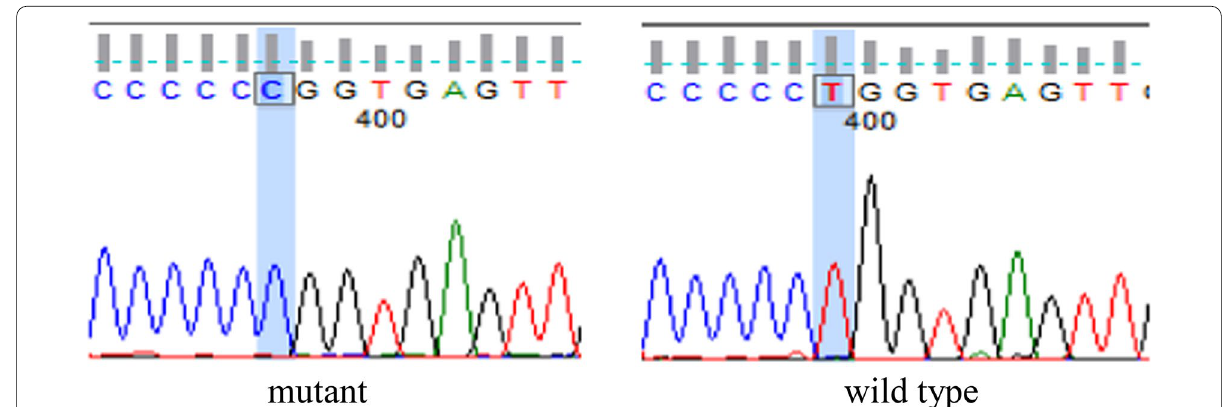
*Novel mutation c.1193 T>C (SCV000998899)